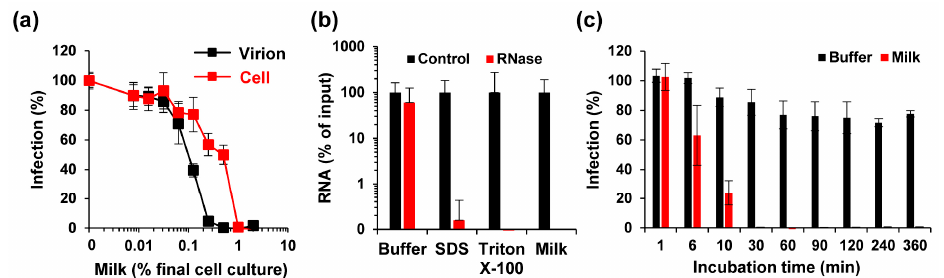
Figure 2. Mechanism of ZIKV inhibition by long-term freeze-stored breast milk. ( a ) For cell treatment (cell), Vero E6 cells were incubated with indicated concentrations of breast milk, and thereafter inoculated with ZIKV MR766. For virion treatment (virion), ZIKV MR766 (1.58 × 10 7 TCID 50 / mL) was incubated 1:1 for 10 min with 10-fold higher breast milk concentrations before the mix was diluted onto Vero E6 cells. Concentrations shown correspond to the final concentrations of milk ( v / v ) in cell culture. Then, 2 h after inoculation, the medium was changed and, 2 days later, the infection rates were determined by a cell-based immunodetection assay that enzymatically quantifies the flavivirus protein E. ( b ) ZIKV MR766 was incubated with PBS (90%), SDS (0.5%), Triton X-100 (1%) or milk (90%) for 1 h at 37 ◦ C. Free (and released) RNA was incubated in bu ff er or degraded by RNase A (10 U) for 1 h at 37 ◦ C. Remaining ZIKV RNA copy numbers were determined by RT-qPCR. ( c ) PBS or breast milk (5%) were incubated with ZIKV MR766 for the indicated time at room temperature before the mixture was inoculated onto Vero E6 cells. After 2 h, the medium was changed and, 2 days later, the infection rates were determined as described in ( a ). Infection data are normalized to infection rates in the absence of the respective sample. All data are represented as average values obtained from triplicates ± standard deviations.